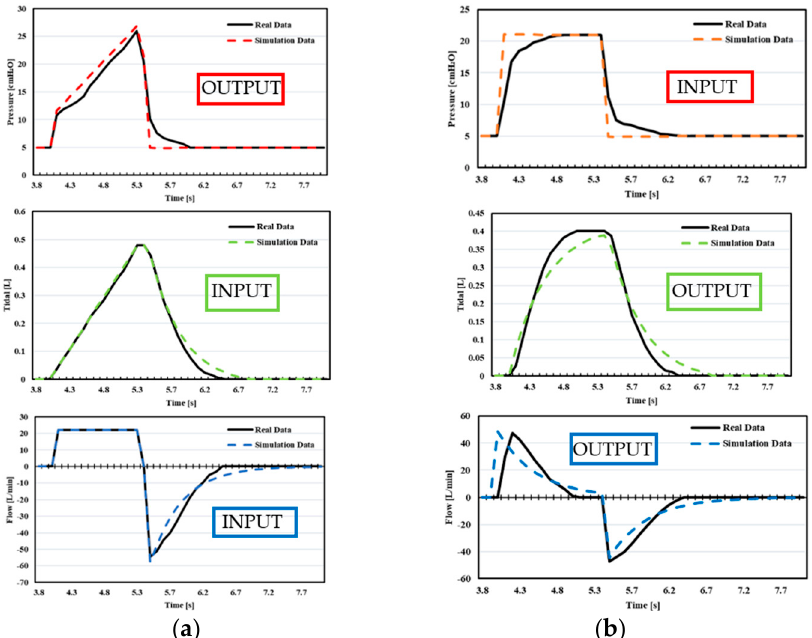
Figure 22. Case 1. Comparison between real ‐ life data and simulation data: ( a ) square flow, ( b ) half decelerating; ( c ) full decelerating; ( d ) sine waveform; ( e ) ramp pressure.